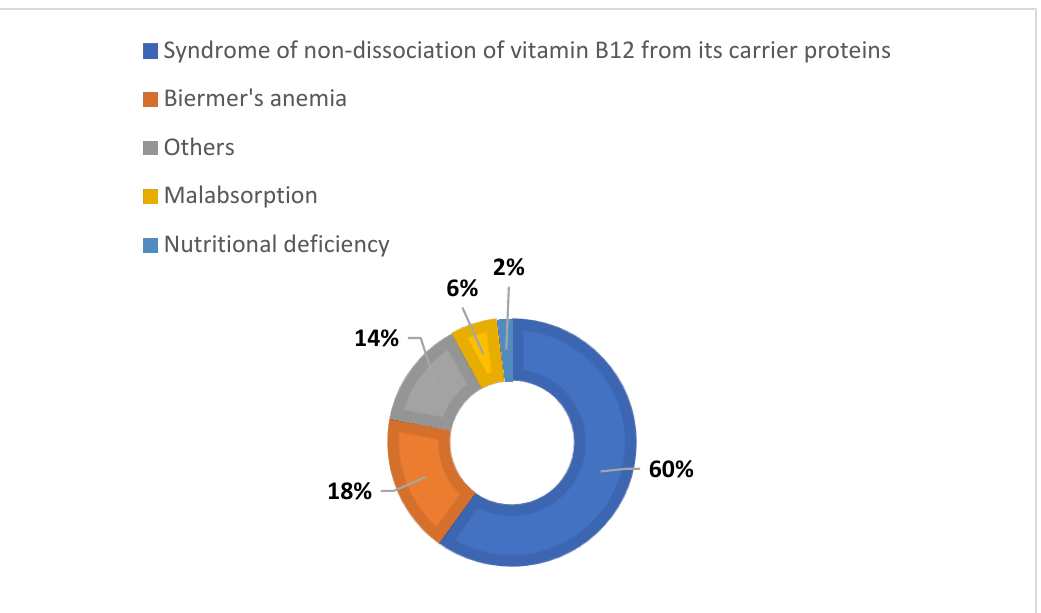
Figure 2. Graphical presentation of main etiologies of vitamin B12 deficiency, according to Rufenacht et al. [9] and Bosco et al. [10].